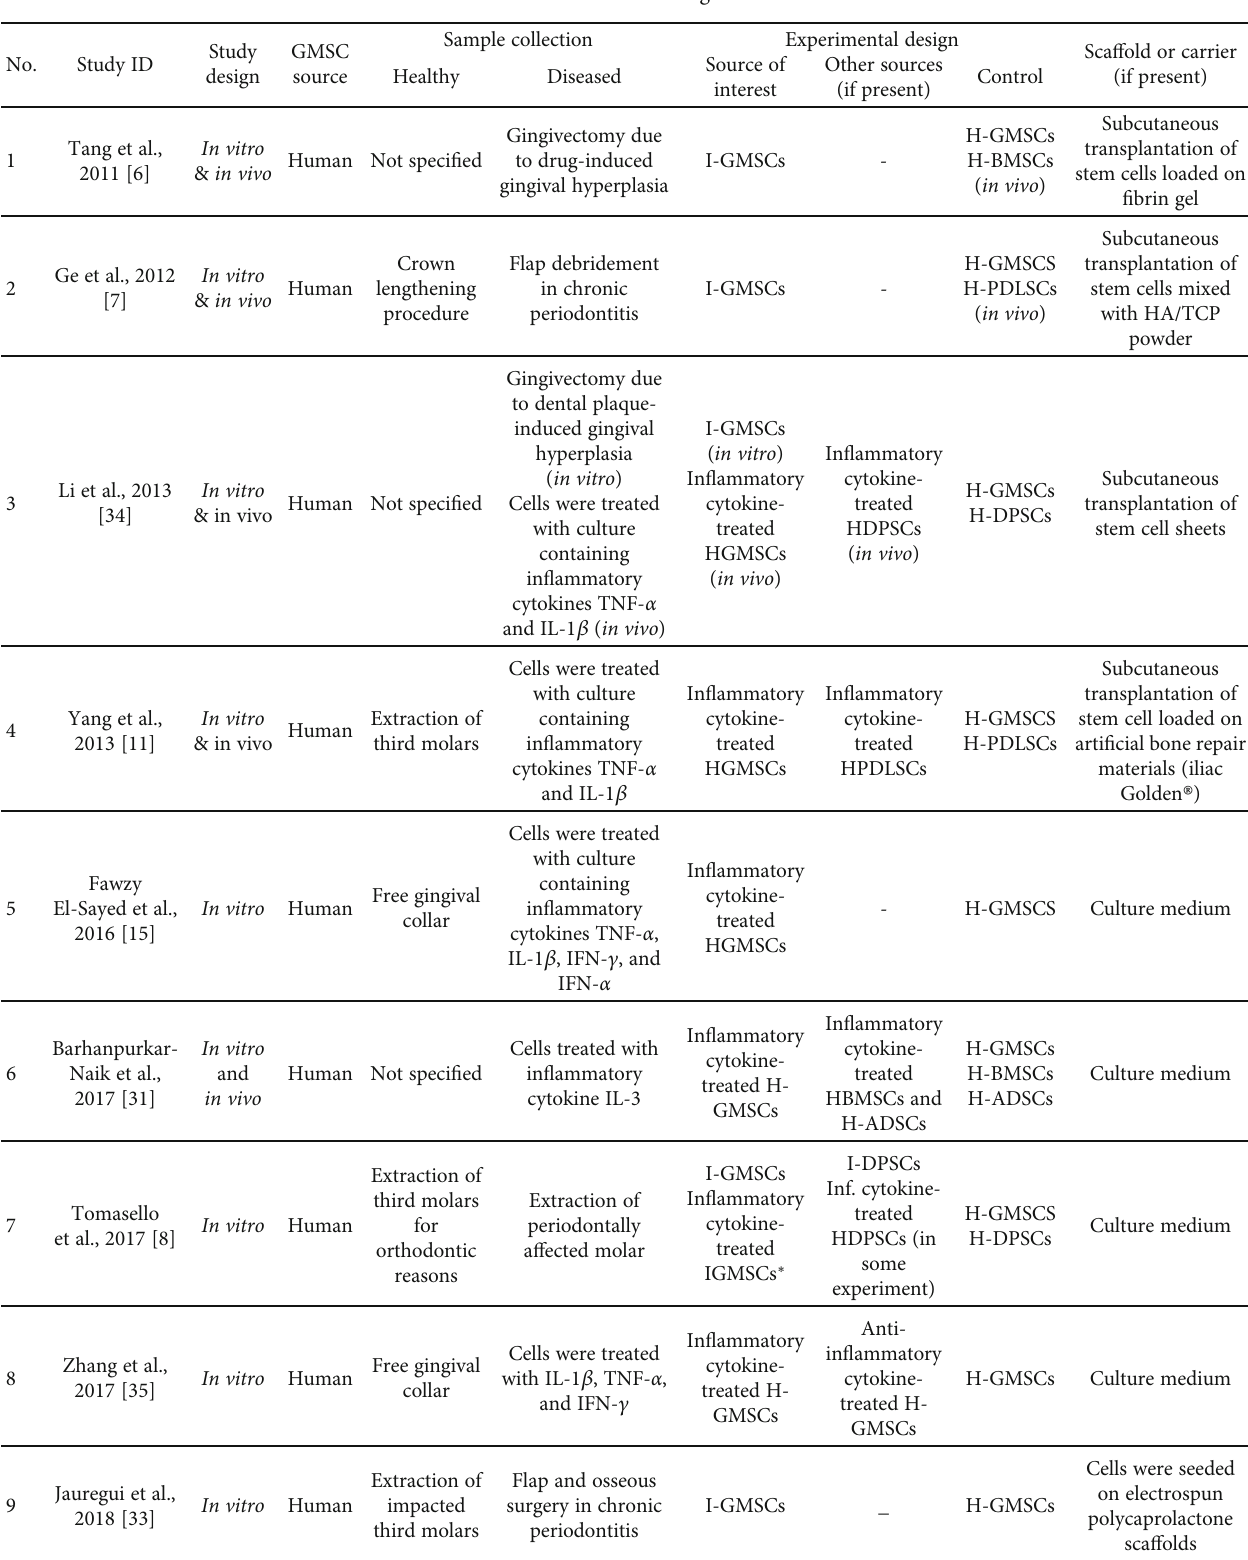
Table 1: Characteristics and methodologies of included